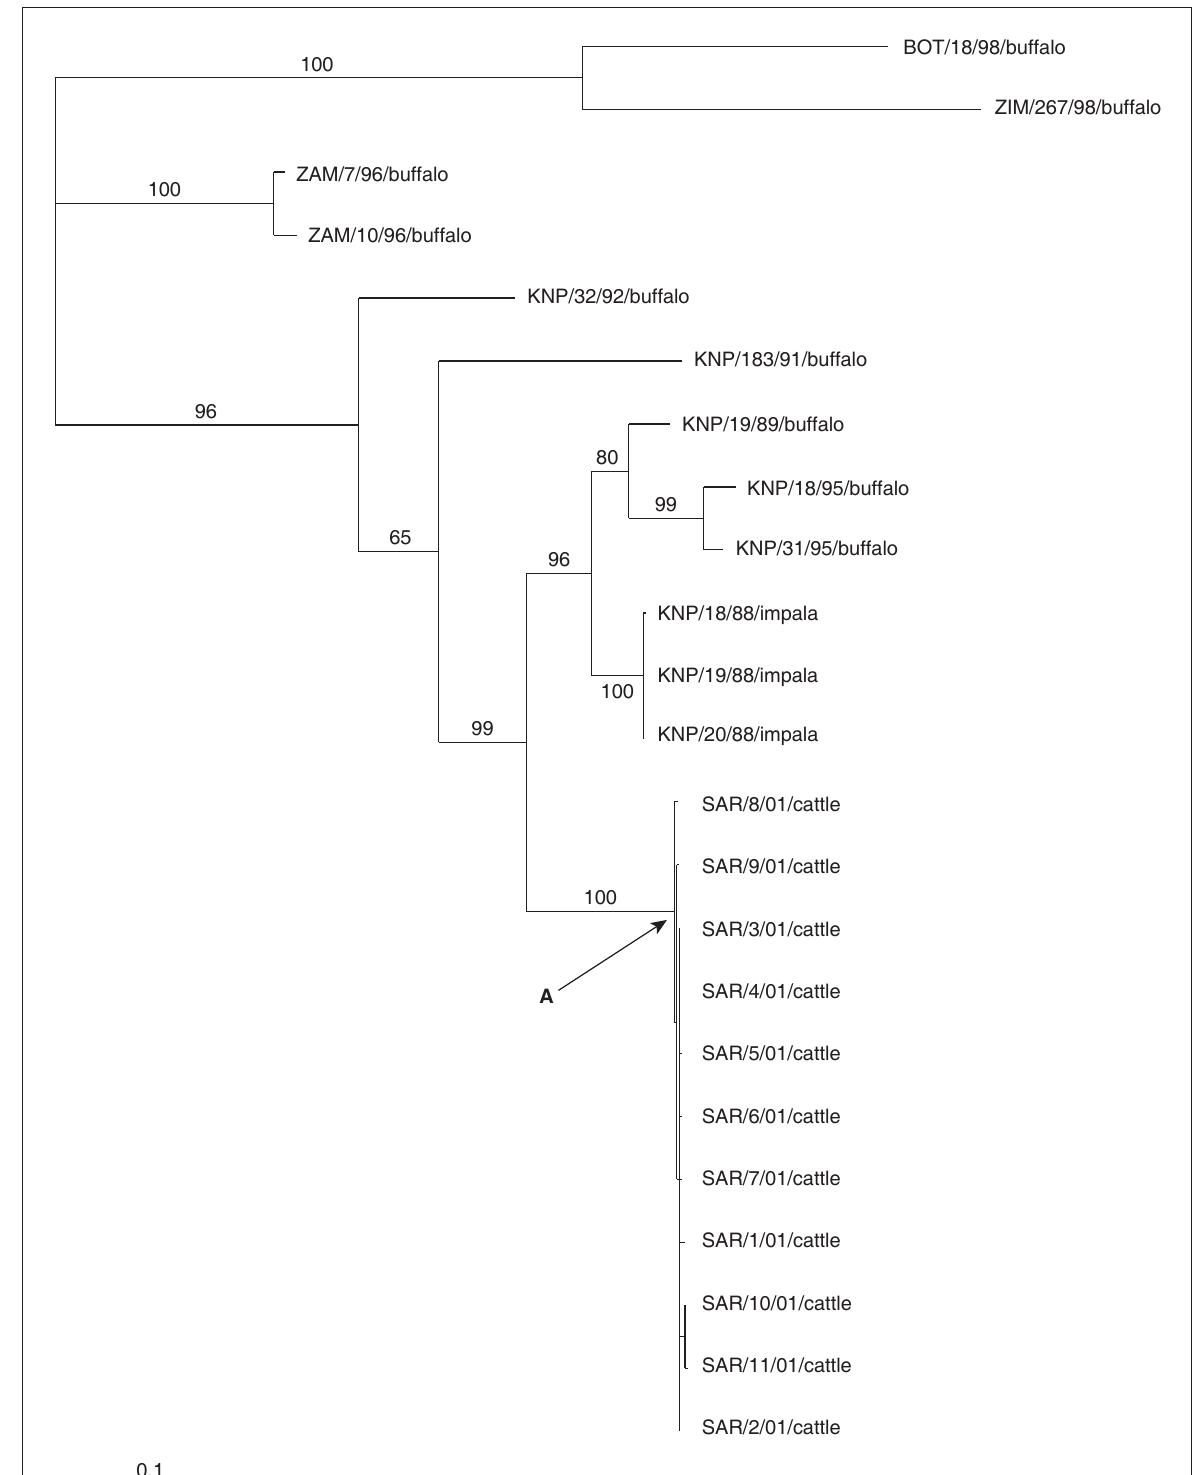
FIG. 1 The maximum likelihood phylogeny of the outbreak sequences and a number of closely related sequences from wildlife obtained in the KNP, Zimbabwe, Botswana and Zambia. Levels of bootstrap support (estimated using the neighbor-joining method) are indicated on the branches. The ‘A’ indicates the position downstream from which a different d to the rest of the